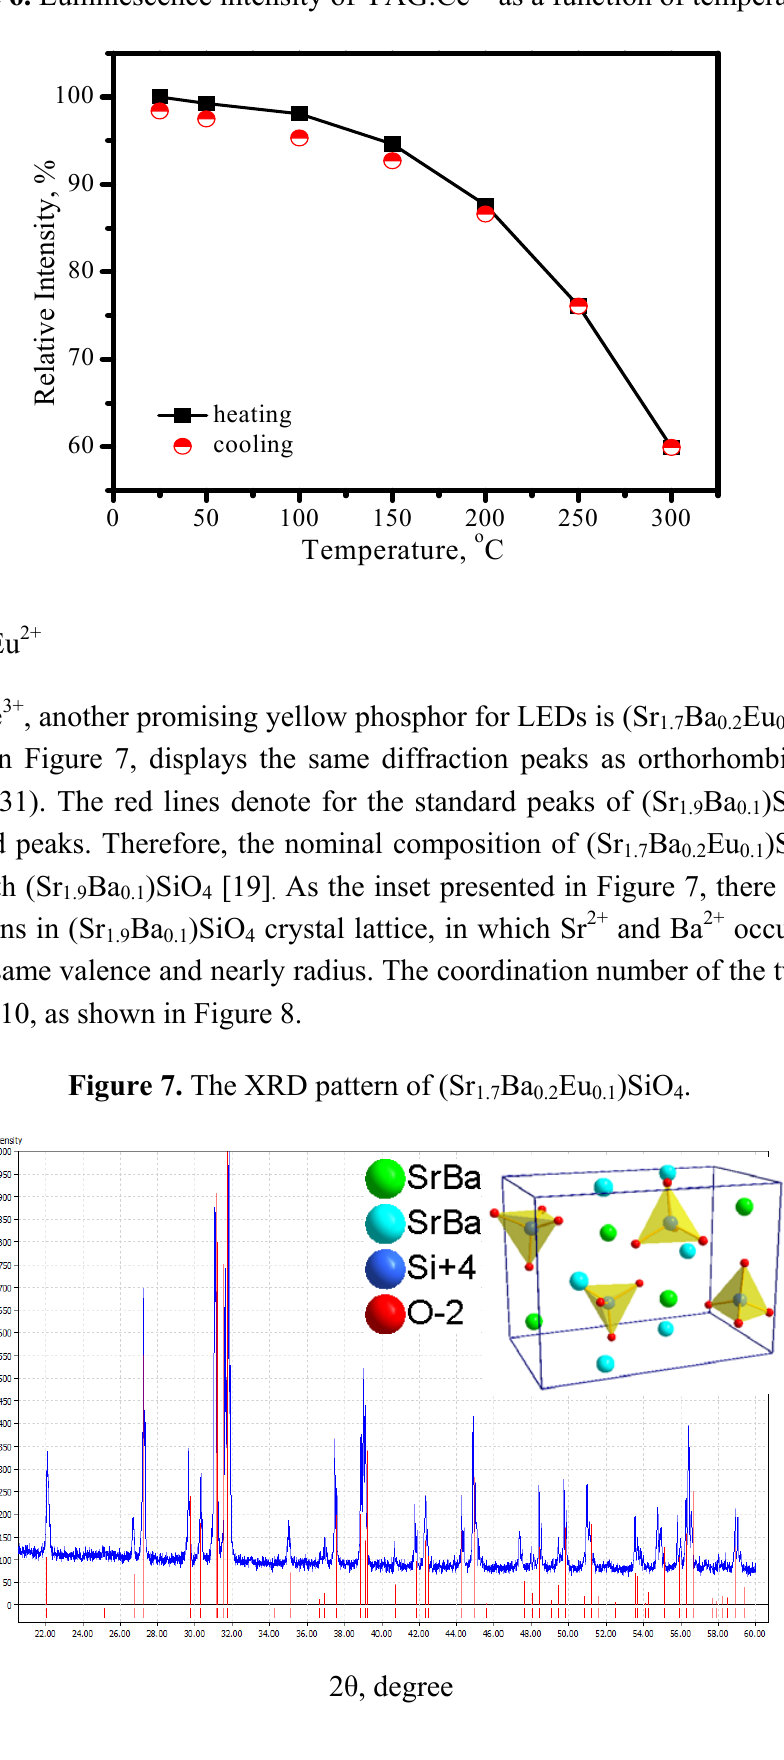
Figure 6. Luminescence intensity of YAG:Ce 3+ as a function of temperature.